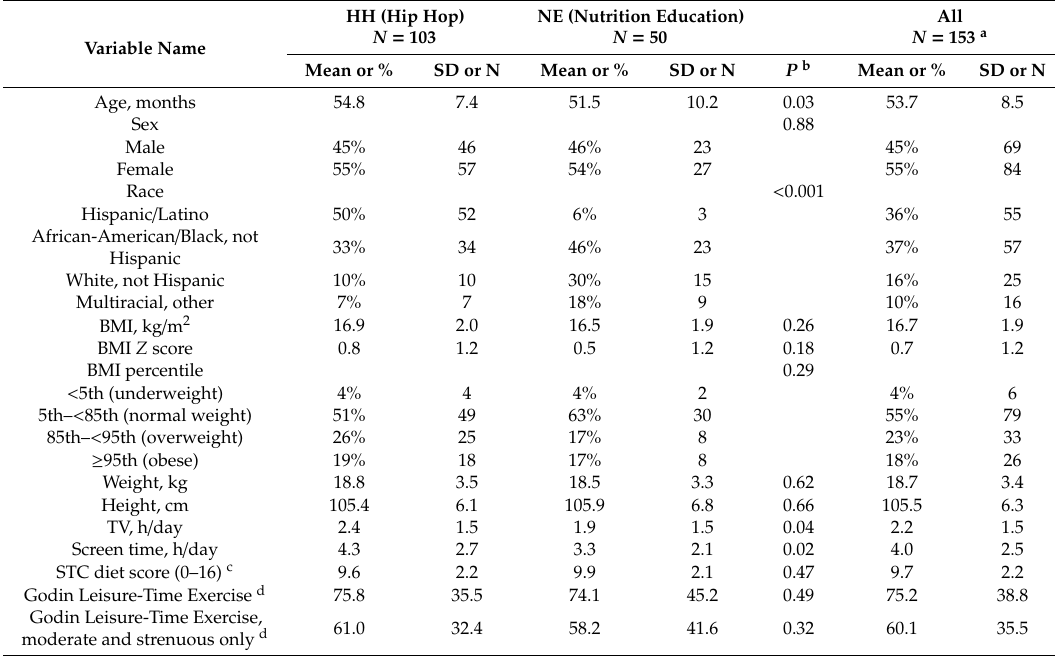
Table 1. Children’s characteristics at baseline, by